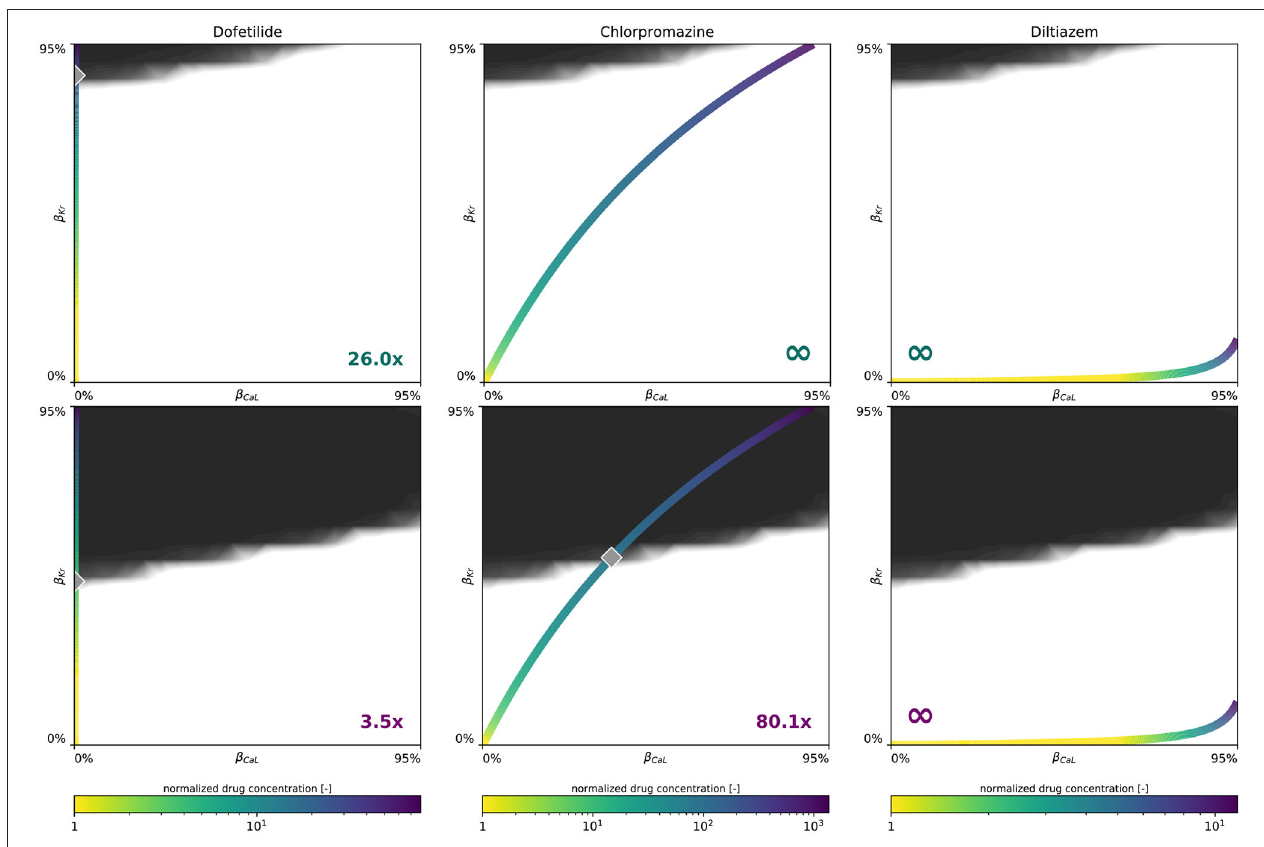
FIGURE 9 | Sex-specific drug-induced arrhythmogenic risk assessment . Male (Upper) and female (Lower) drug-induced arrhythmogenic risk assessment for dofetilide, a high risk drug, chlorpromazine, an intermediate risk drug, and diltiazem, a low risk drug. The color-coded line represents drug-specific concentration-dependent I CaL / I Kr ion channel blocking trajectory, normalized with respect to the drug’s effective free therapeutic plasma concentration. The gray diamond shaped marker highlights the critical concentration, annotated in the plot’s bottom corner, at which the drug’s block-concentration trajectory crosses the mean multi-fidelity arrhythmogenicity classification